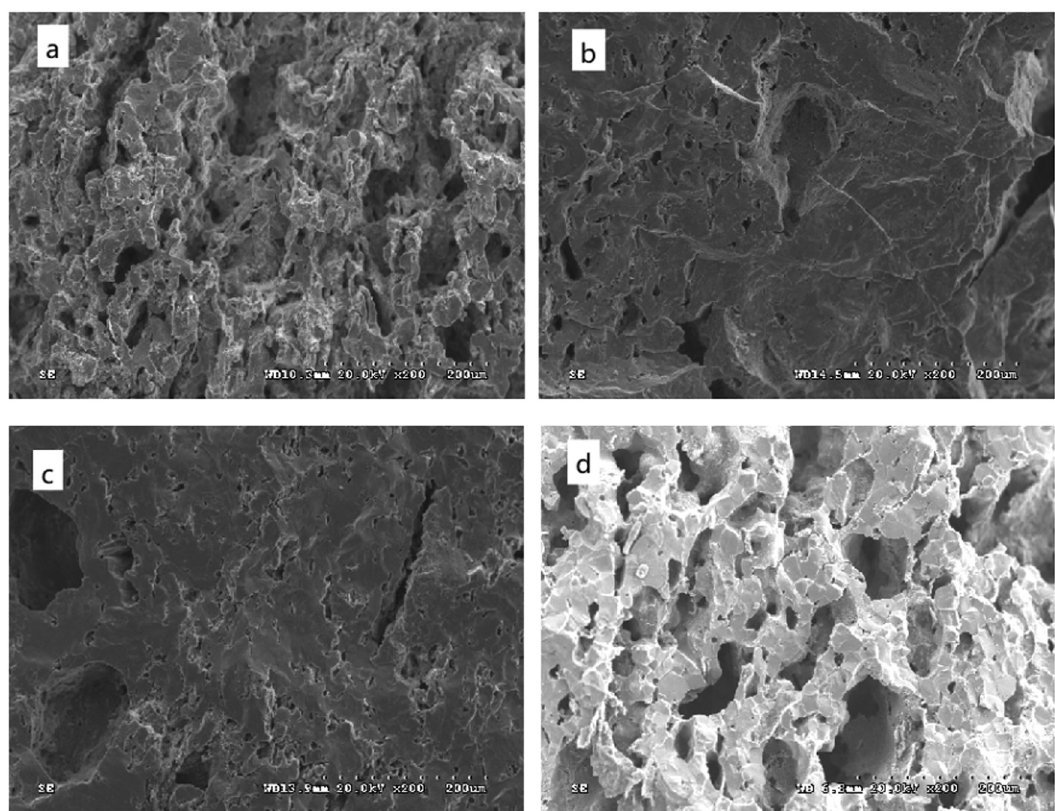
Figure 6: SEM fracture micrographs of intermetallics with different Co/Al molar ratios: ( a ) 1:1, ( b ) 1:3, ( c ) 4:13, and ( d ) 2:9.